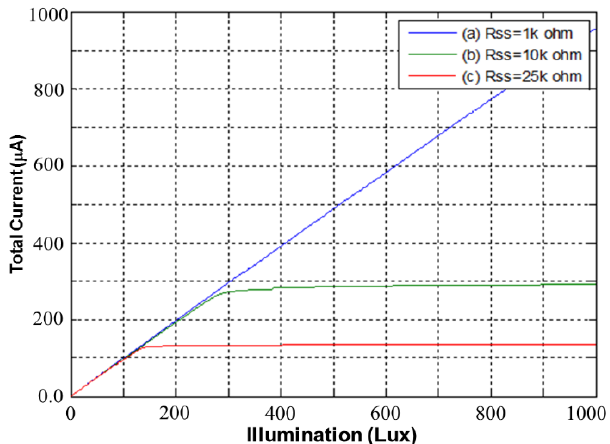
Figure 11. Simulated total currents versus illumination (lux) for the proposed CMOS light detector.